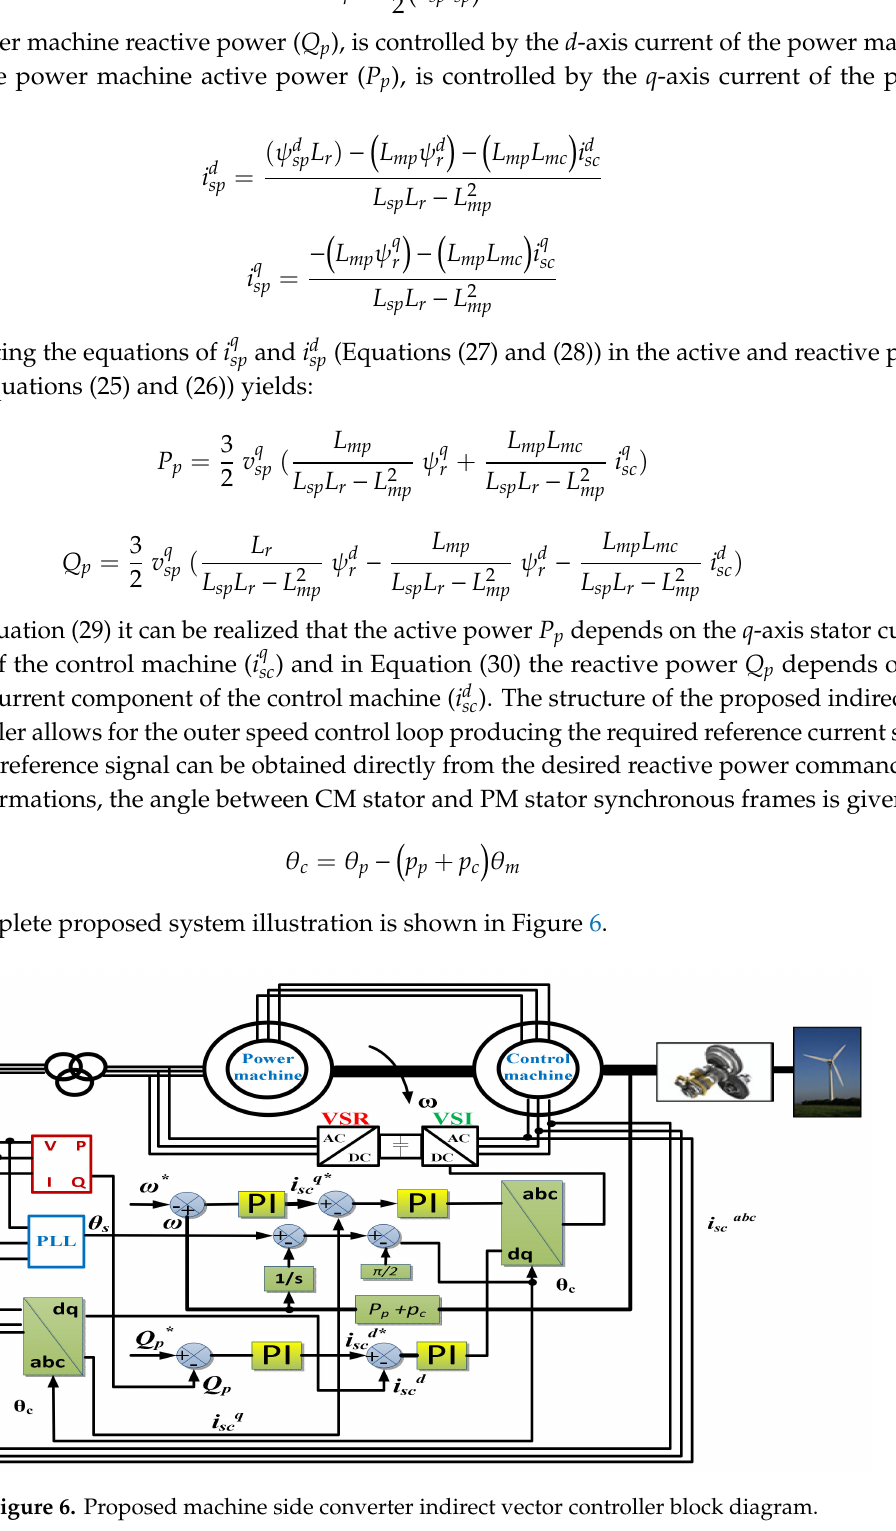
Figure 6. Proposed machine side converter indirect vector controller block